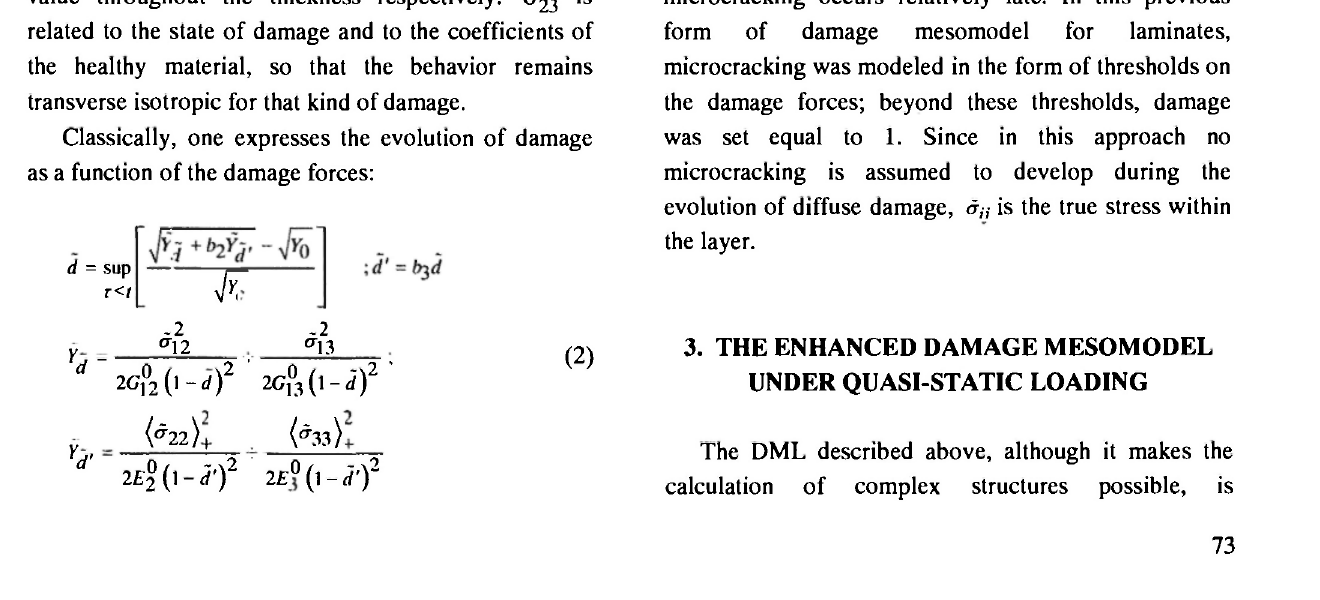
Fig. I: [a] model of a stacking sequence on the mesoscale [b] example of mesodecomposition for a [0/90 2 /0] cross-ply laminate Then, the level of degradation of each mesoconstituent is quantified by damage indicators, which can be related to the loss of stiffness. The